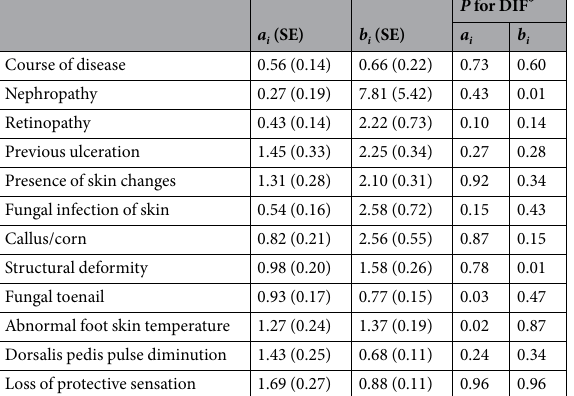
Table 3. Item response model parameters and differential item functioning. a i : discrimination parameter; b i : difficulty parameter; SE: standard error. DIF: differential item functioning. * P values of chi-square tests to examine differential item functioning with respect to gender-specific discrimination ( a i ) and difficulty ( b i )